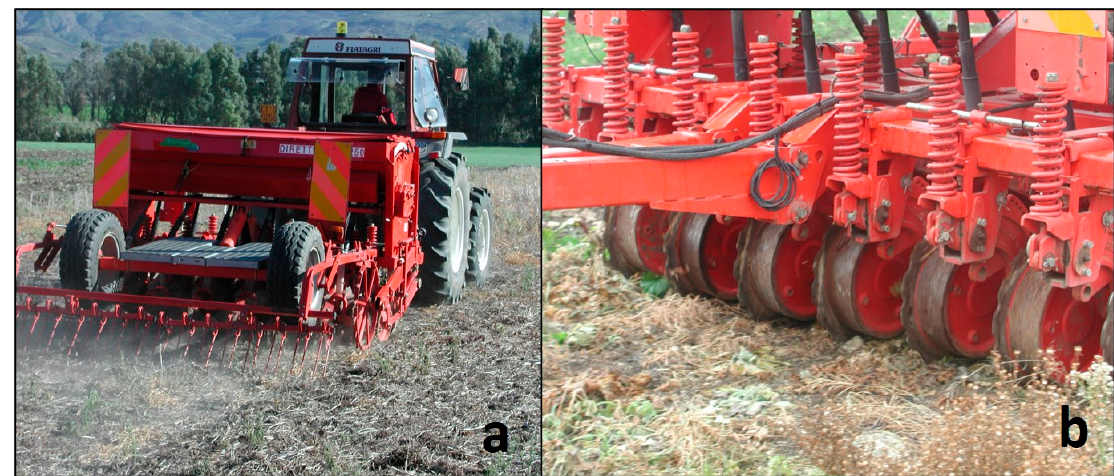
Figure 1. No-tillage (NT) drill Directa 2.5 m wide at work in Sicily on soil covered by chopped crop residues ( a ) and detail of the working tools constituted by ballasted discs ( b ).